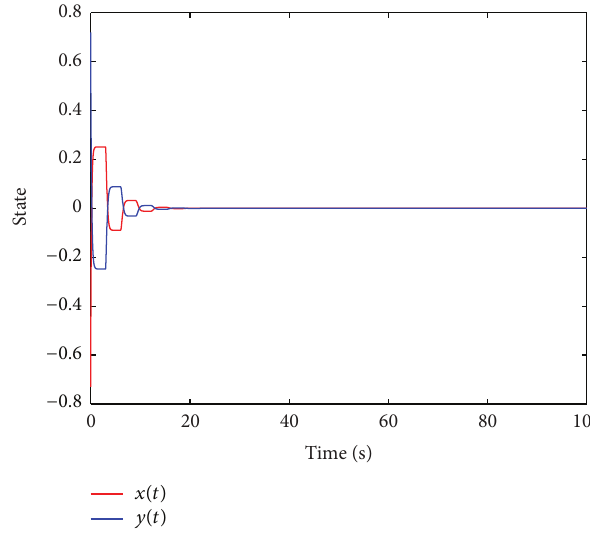
Figure 5: Simulation of the system (75) under the periodically intermittent control.